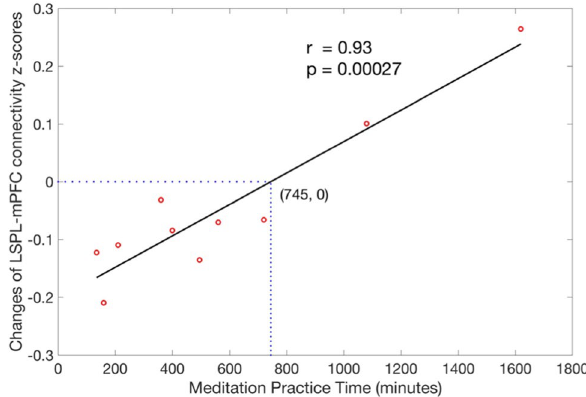
Figure 6. Association of longitudinal functional connectivity change with meditation practice time after adjusting for gender effects. Association, calculated from Pearson partial correlation, was observed significant (r = 0.93, p = 0.00027) and remained significant (r = 0.94, p = 0.00053) for all the